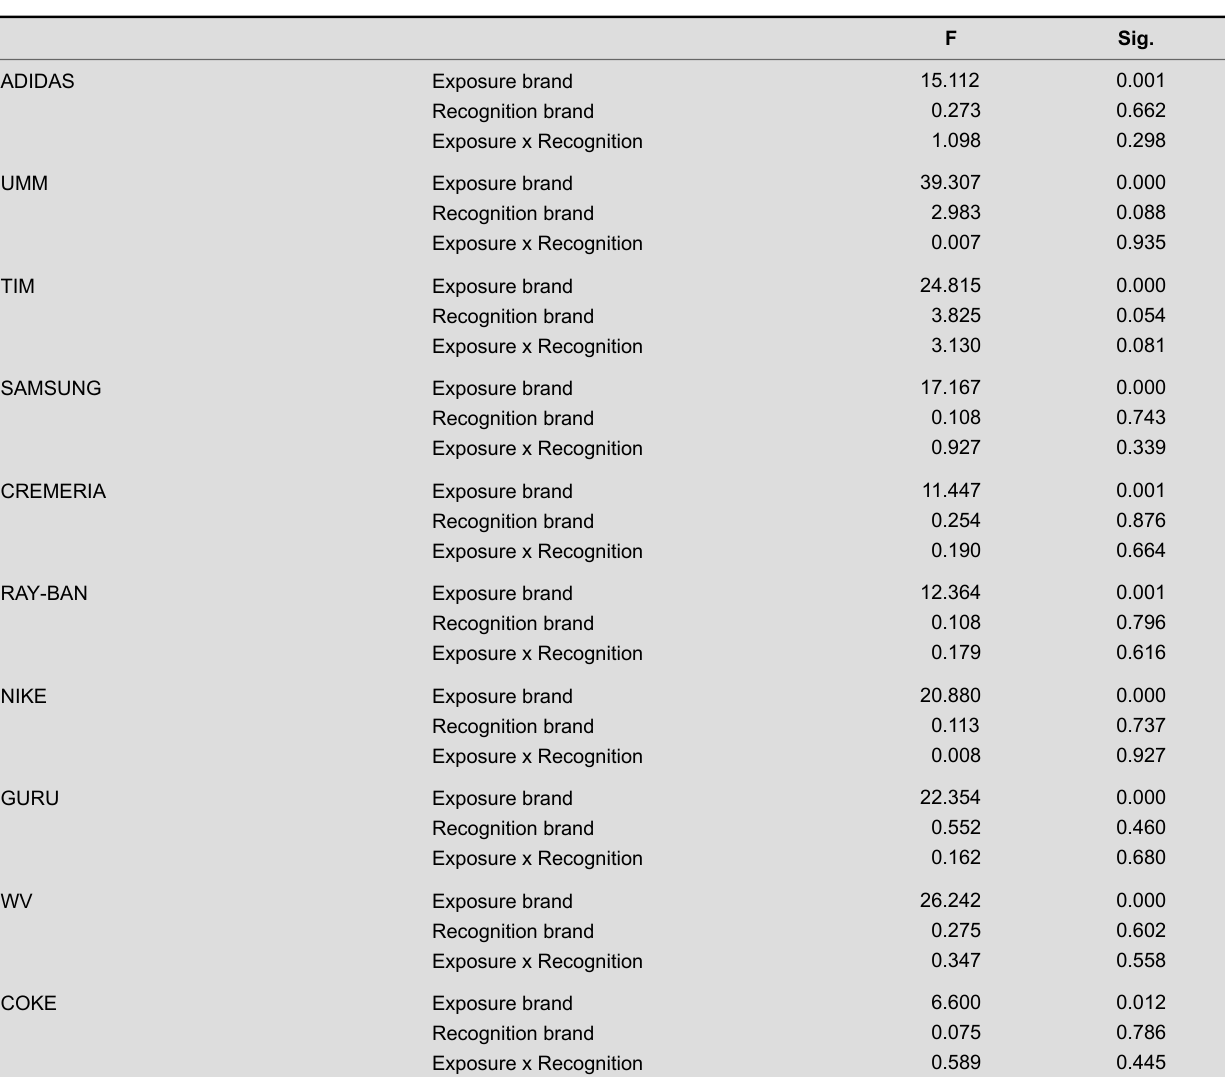
Effect of Exposure and Recognition of